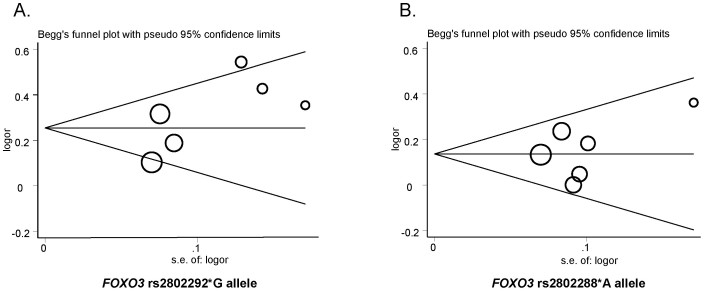
Begg's funnel plot of rs2802288*A and rs2802292*G to detect publication bias.(A) rs2802292*G; (B) rs2802288*A. Each circle represents an individual study for the indicated association and whose size proportionally represents the weight of each study. logor, natural logarithm of OR; s.e., standard error; Perpendicular line, mean effect size.